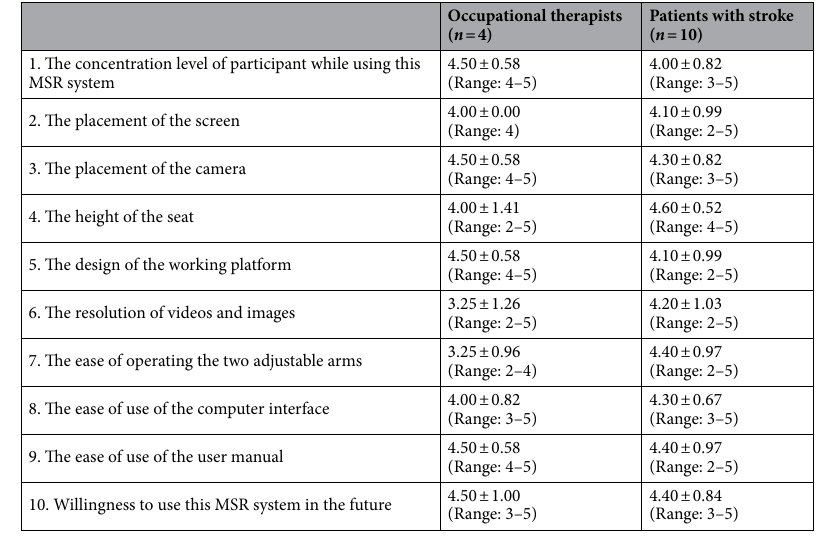
Table 5. Mean ratings on each item of the self-designed questionnaire in occupational therapists and patients with stroke. The listed statistics are mean ± standard deviation (SD). Abbreviations: MSR, multi-mode stroke rehabilitation. Note: The score of each item is ranged from 1 to 5. Higher scores are indicative of more concentrated for item 1, more appropriate for items 2 to 5, better resolution for item 6, easier for items 7 to 9, and more willing for item